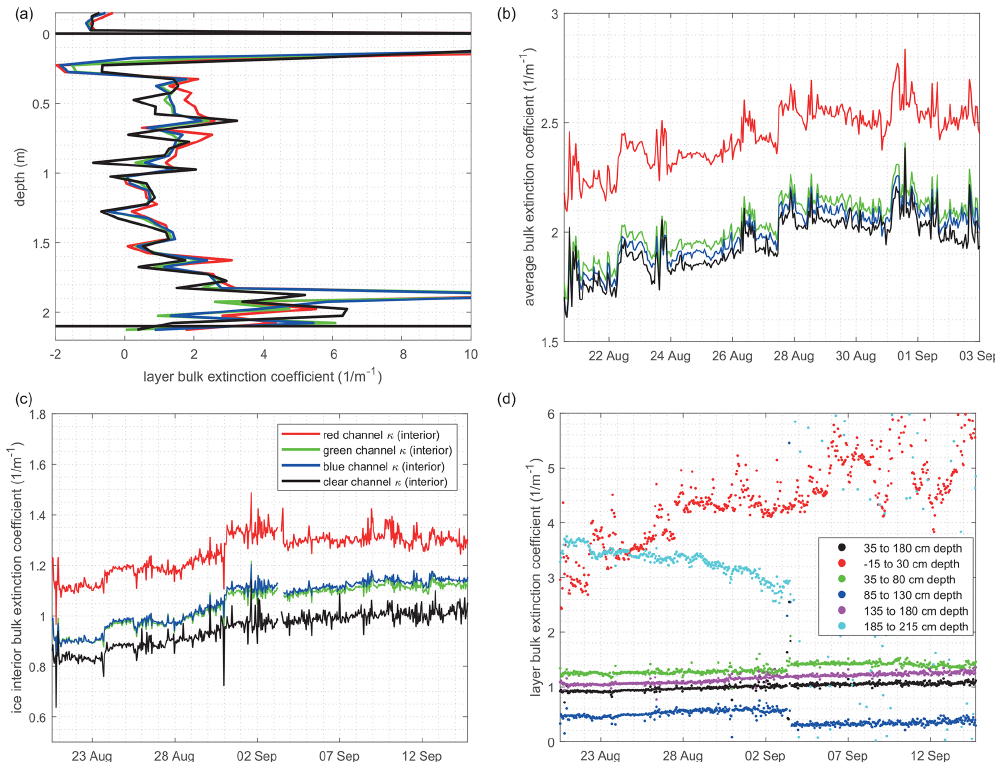
Figure 8. (a) Time-averaged attenuation coefficients for the first complete set of time series until 14 September for all four channels. (b) Bulk attenuation coefficient averaged over the entire vertical domain. From top to bottom: red, green, blue and clear channel. (c) Ice interior attenuation coefficient for all four channels, determined as the average of attenuation coefficients from 0.35 to 1.8m depth. (d) Time series of clear-channel attenuation coefficient for different vertical ice layers. The black line equals the black line in panel (c) . Sudden changes on 3 September 2020 are caused by partial failure of the sensor